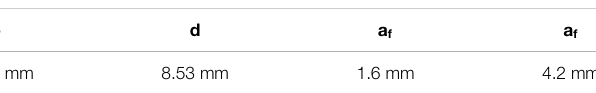
TABLE 2 | Heat source parameters.